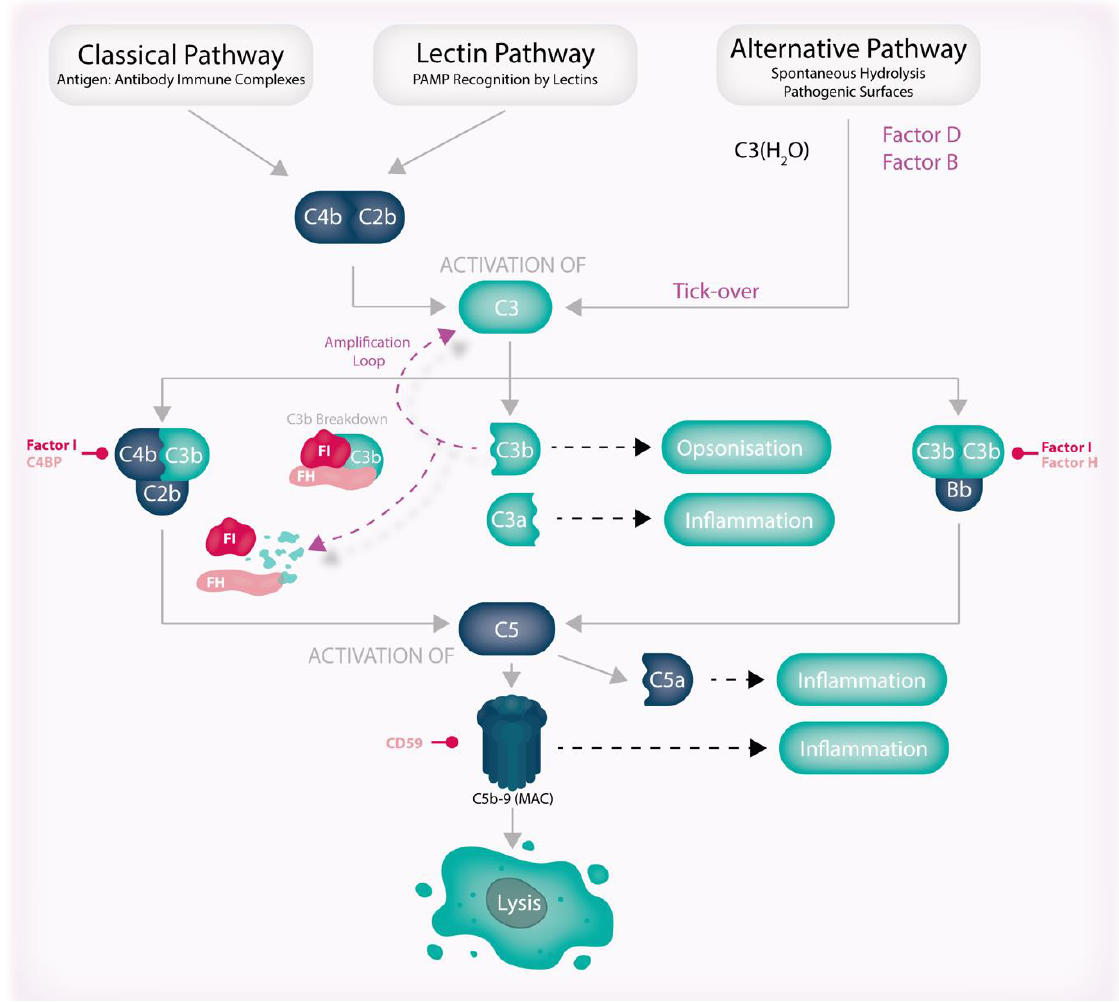
Figure 5. The pathways of the complement system. The complement system is a network of prote- olytic pathways that work together to maintain the body’s homeostasis. The alternative pathway is continuously activated through the hydrolysis of C3 to C3(H 2 O) in a process known as “tick-over” and triggers the formation of C3 convertases (C4b:C2b, C3b:Bb (not shown)) and C5 convertases (C4b:C2b:C3b and C3b:Bb:C3b), leading to the production of anaphylatoxins, effector